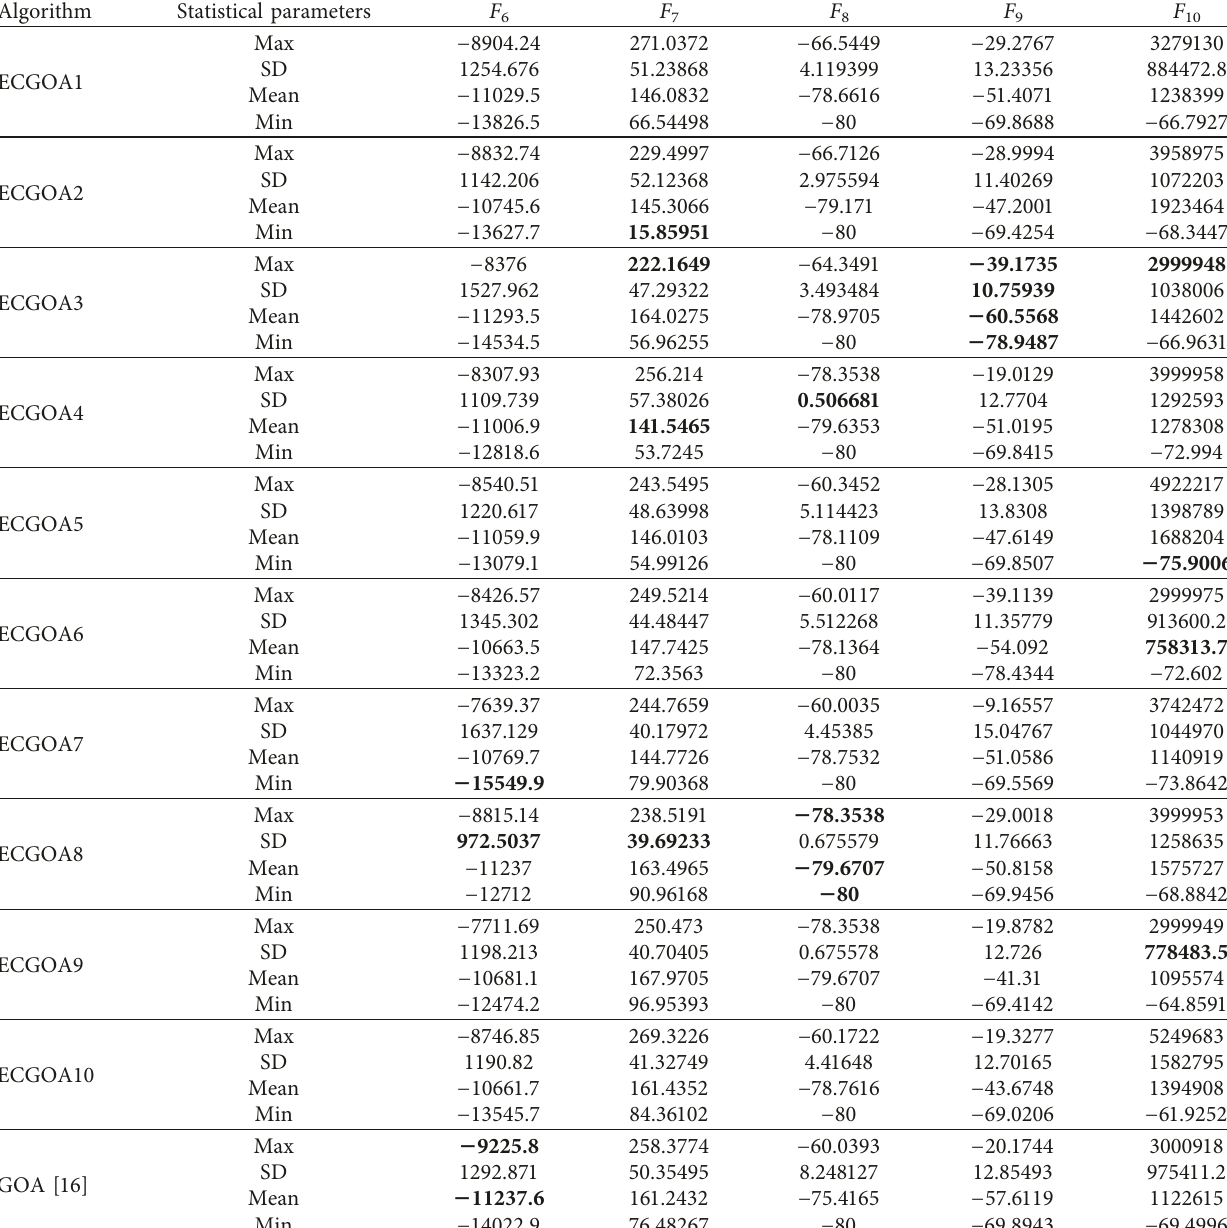
Table 5: Results and comparison of ECGOAs with GOA (30-D) for multimodal functions.